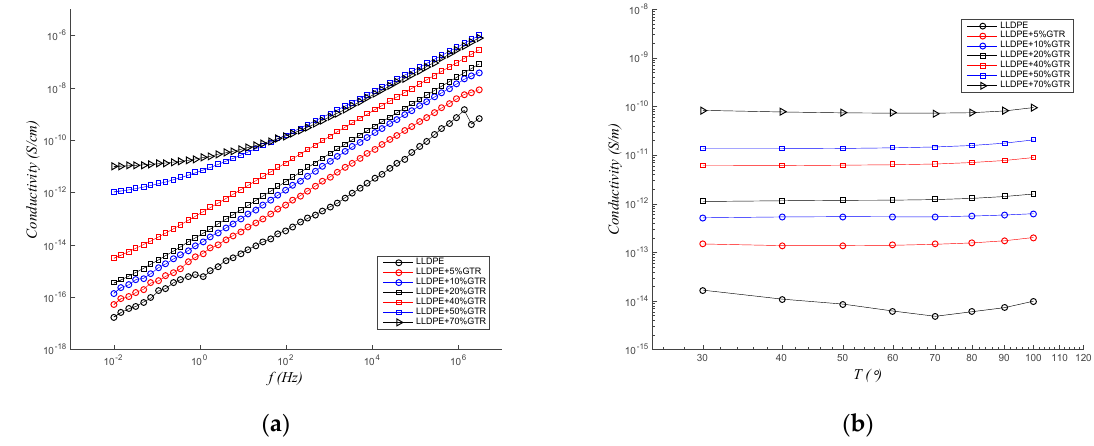
Figure 4. Frequency and thermal response of the conductivity of LLDPE/GTR compounds ( a ) at 30 °C with a frequency range of 10 − 2 to 3 ×·10 6 Hz and ( b ) at 50 Hz with a temperature range of 30 to 100 °C .